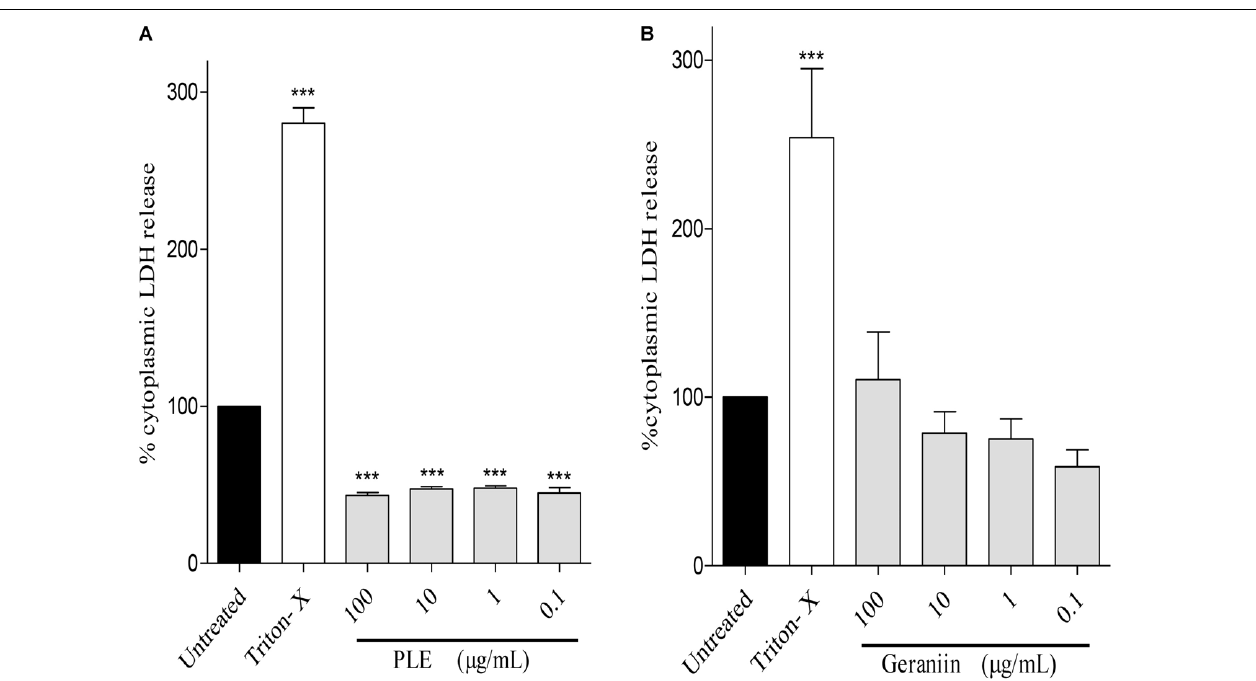
FIGURE 8 | Influence of PLE (A) and geraniin (B) on LDH release from HaCaT-keratinocytes. HaCaT-keratinocytes were seeded into 96-well plates and incubated to achieve 90% confluency. Cells were then treated with PLE (0.1 to 100 µ g/mL) and geraniin (0.1 to 100 µ M). Fetal calf serum (1% FCS) was used as positive control. The absorbance was measured at 490 against 690 nm. PLE, aqueous extract of the aerial parts of P. muellerianus . Values are mean ± SEM, n = 3. ∗∗∗ p < 0.001 compared to untreated cells (one-way ANOVA followed by Dunnett’s post hoc